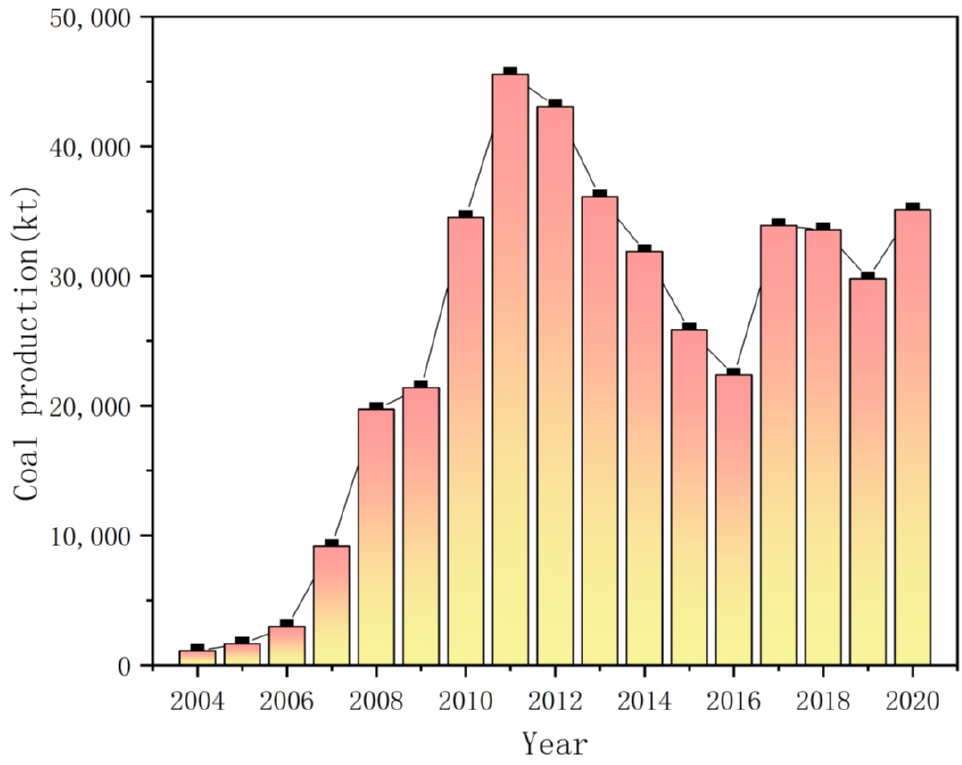
Figure 2. Annual coal production in the research area.